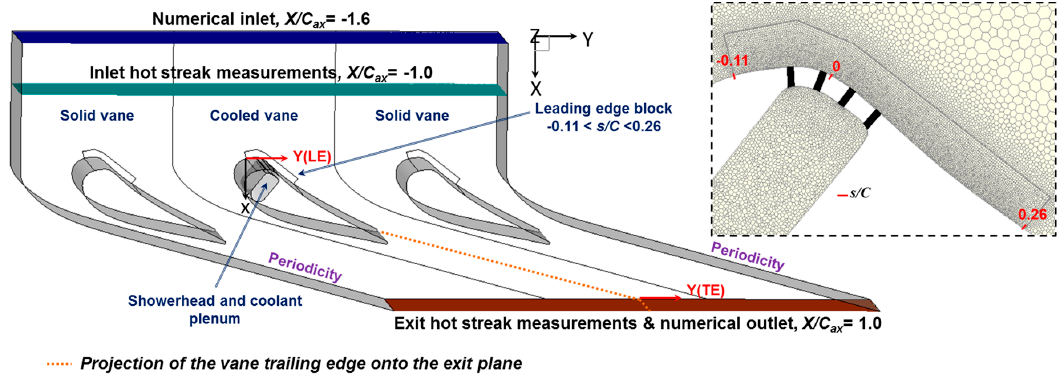
Figure 5. Simulated three ‐ passage vane cascade with hot streak inlet/outlet plane and cross ‐ section view of the mesh in the leading edge region.